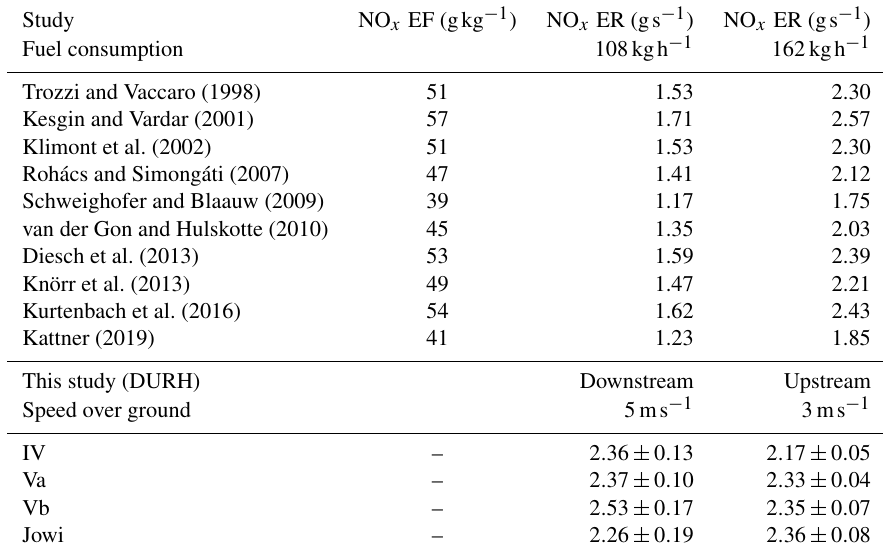
Table 5. Comparison of the derived NO x emission rates (ERs; in gs − 1 ) with the emission factors (EFs; in kgh − 1 ) derived from other studies. To calculate the ERs from the EFs, two fuel consumption scenarios are evaluated. Both scenarios are based on specific fuel consumption values for ships with a cargo capacity of 3200t (approximately class Va and Vb). First, a fuel consumption of 108kgh − 1 is assumed for ships that travel downstream, and second, a fuel consumption of 162kgh − 1 is assumed for ships travelling upstream.